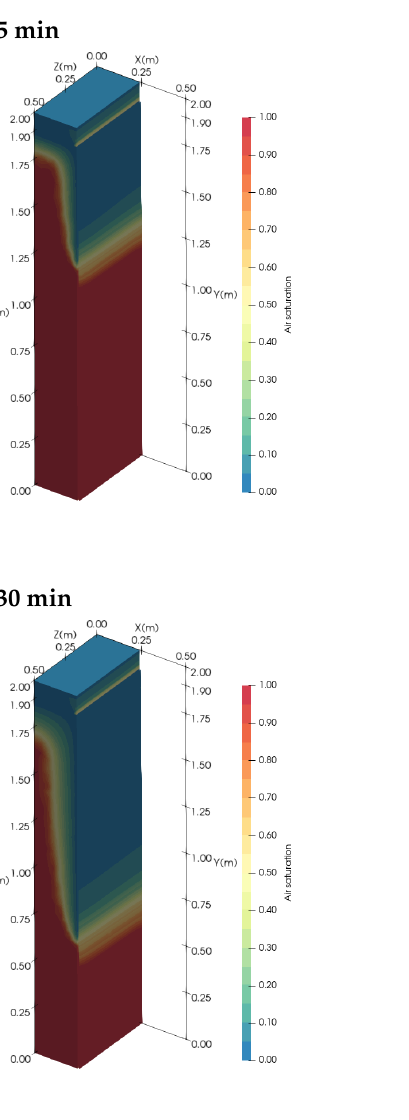
Figure 20. Model TUFF3D, low rainfall intensity. Saturation profiles at different time steps. Constant aperture model ( left ), variable aperture ( right